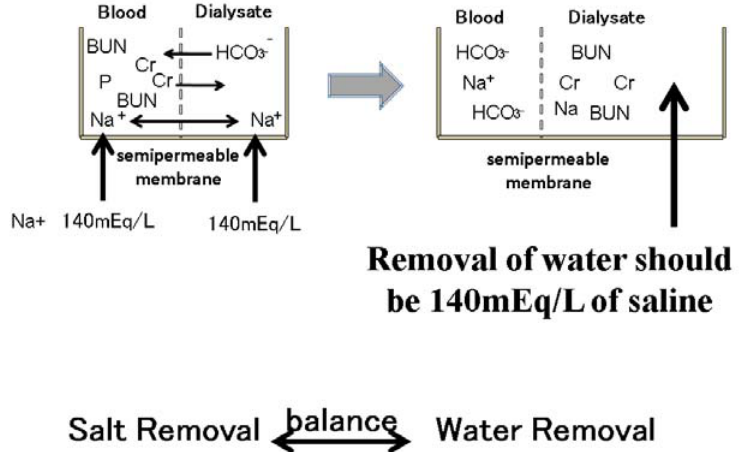
Figure 7. Removal of sodium during dialysis sessions. Small molecular substances, such as blood urea nitrogen and phosphate creatinine, are moved to the dialysate according to the concentration gradient. Bicarbonate also moves to the blood from the dialysate according to the concentration gradient. The sodium concentration in the dialysate is 140 mEq/L. The serum sodium concentration is also approximately 140 mEq/L. Therefore, sodium cannot move from the blood to the dialysate through the semipermeable membrane in the dialyzer. However, water removal during dialysis sessions includes 140 mEq/L sodium. Water removal during dialysis sessions means sodium removal at the same time.